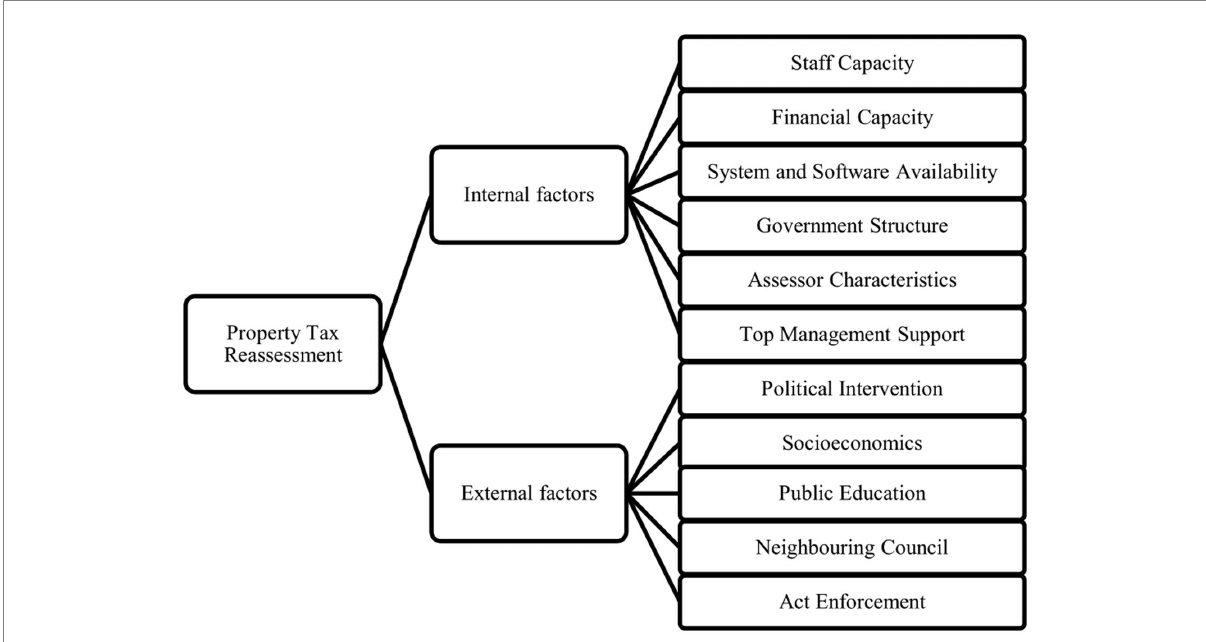
FIGURE 1 Determinants of property tax reassessment. Reproduced with permission from Senawi et al.